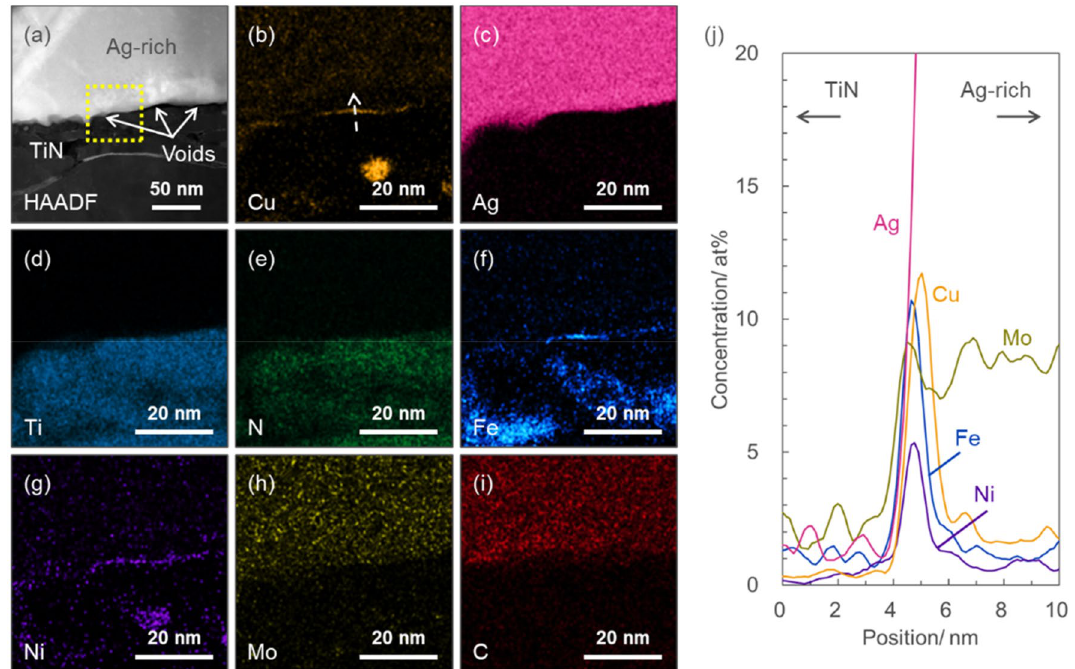
from the selected area marked in ( a ) by EDS. j Line EDS profile obtained along the white dashed arrow shown in ( b